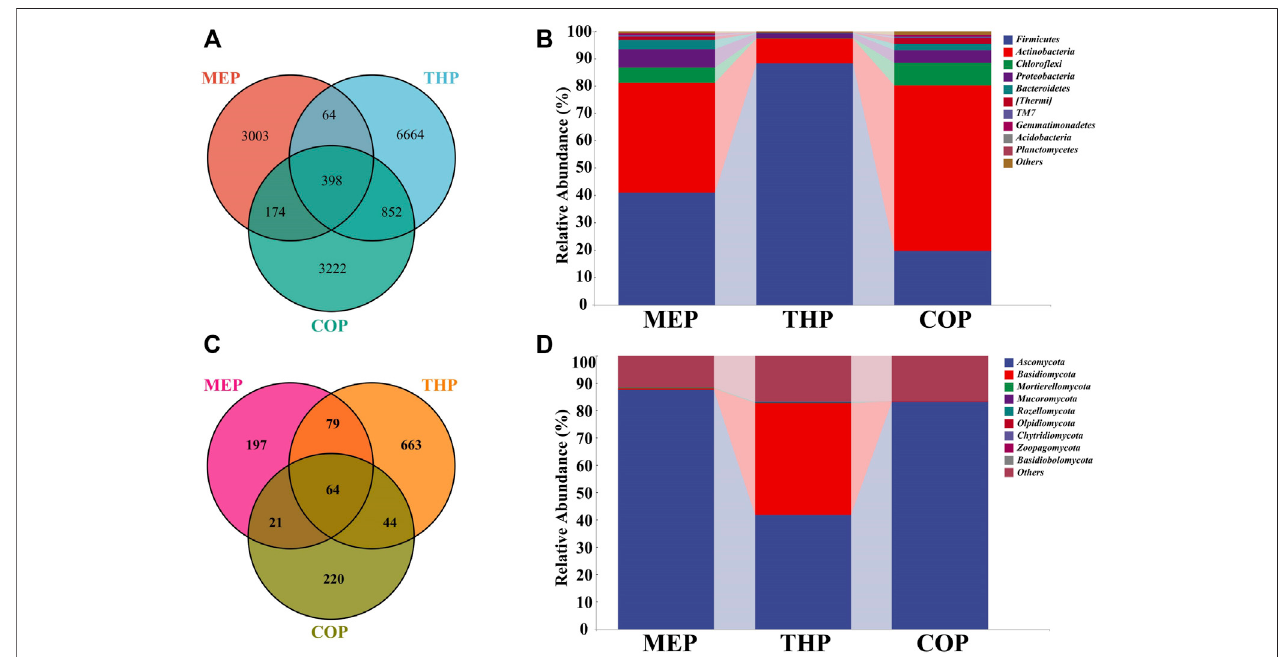
FIGURE 4 | The microbiome composition during composting. (A) Bacterial and (C) fungal Venn diagram of different phases; (B,D) are compositions of bacterial and fungal communities during composting at the phylum-level, respectively.